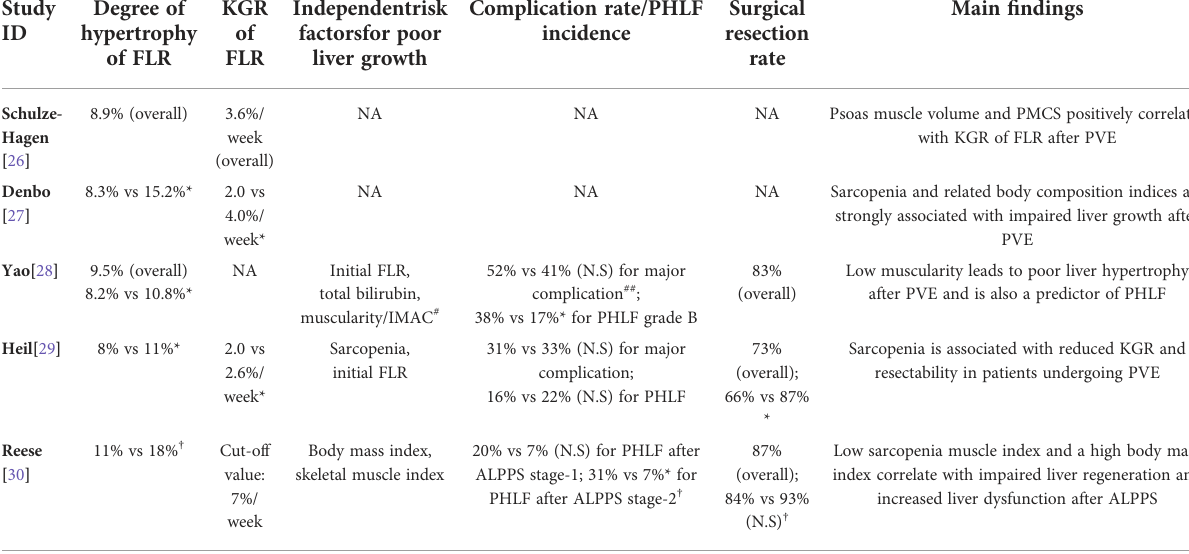
TABLE 3 Future liver remnant growth, post-treatment complication rate and post-hepatectomy liver